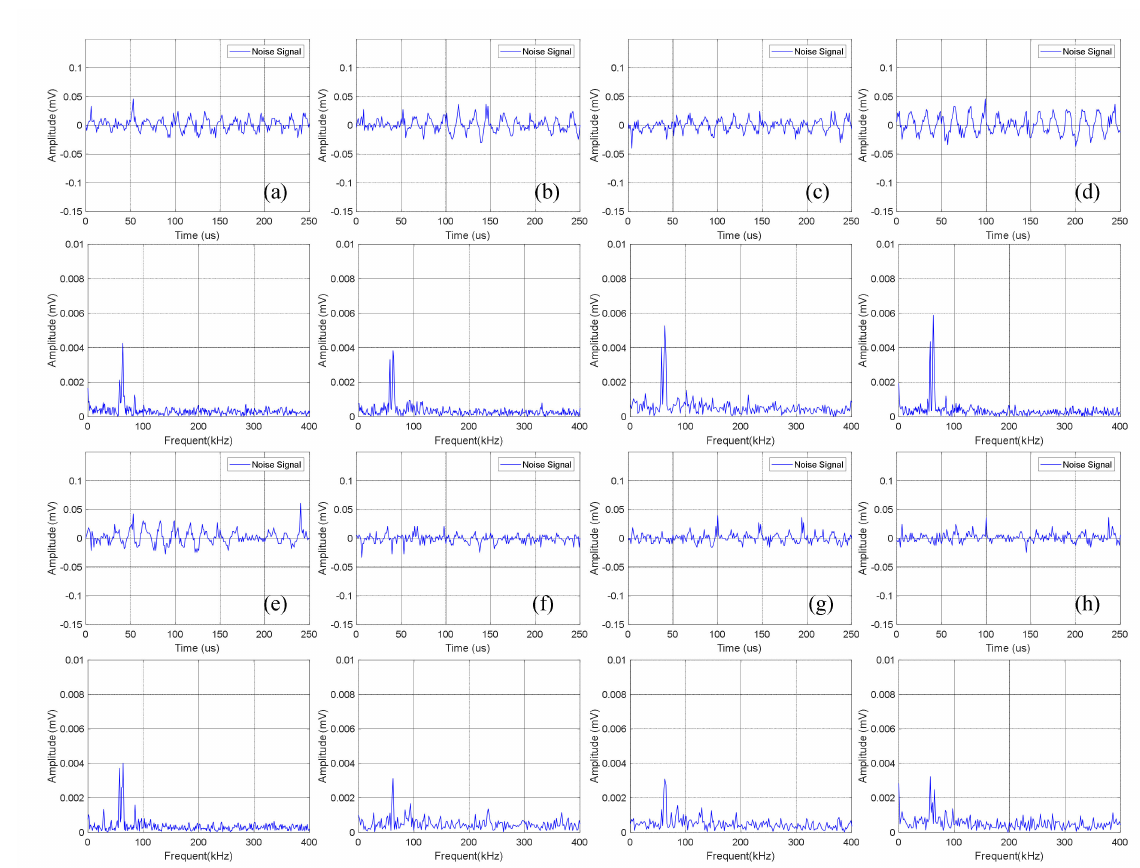
Figure 7. Time domain-frequency domain diagram of 0–600 cycles of charge of Group B batteries: ( a ) 0 cycles; ( b ) 10 cycles; ( c ) 100 cycles; ( d ) 200 cycles; ( e ) 300 cycles; ( f ) 400 cycles; ( g ) 500 cycles; ( h ) 600 cycles.